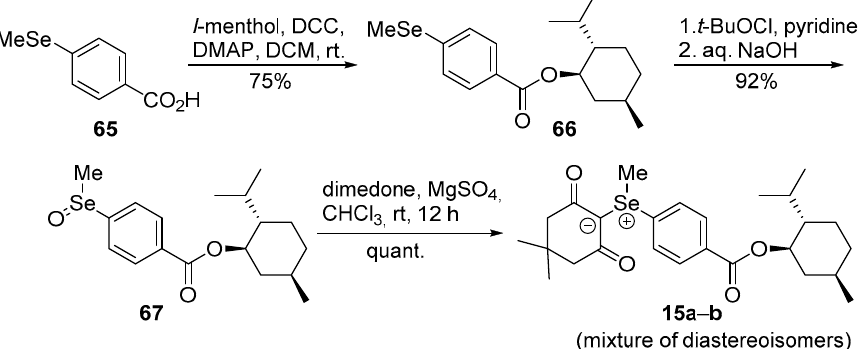
Scheme 19. Synthesis of optically active diastereoisomeric selenonium ylides 15a , b .